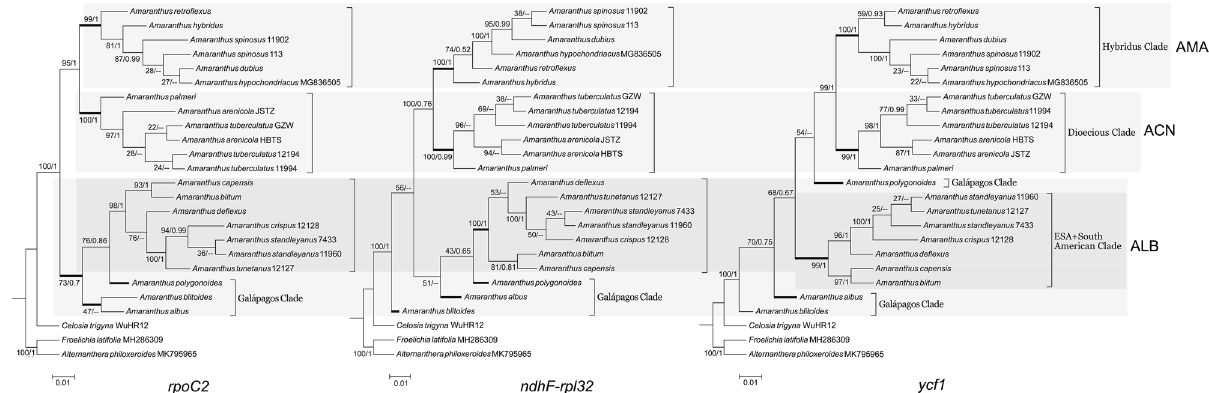
Figure 4. Three maximum likelihood topological trees based on rpoC2 , ndhF-rpl32 and ycf1 of Amaranthus and three outgroups. Values at each node indicate maximum likelihood bootstrap support (BS)/Bayesian inference posterior probability (PP) value. “AMA” represented the subgen. Amaranthus , “ACN” represented the subgen. Acnida , “ALB” represented the subgen. Albersia . The newick format files are imported into MEGA version 6 to generate the final topology